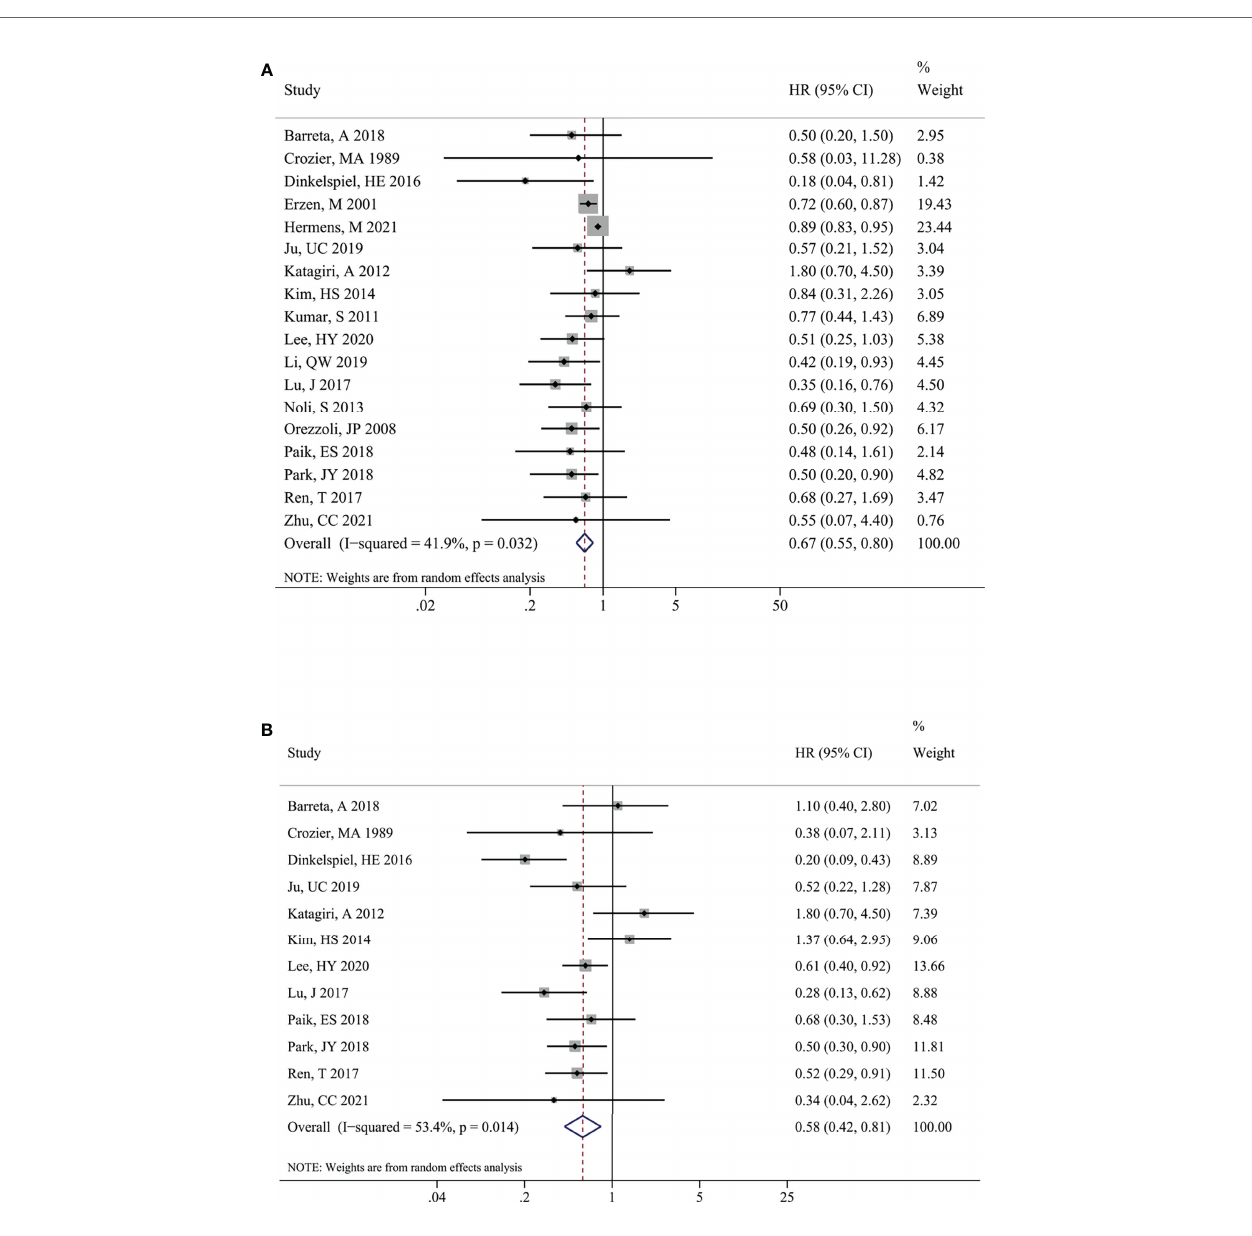
FIGURE 2 | Impact of endometriosis on the prognosis of total OC. Forest plots showing the pooled results for endometriosis on overall survival (A) and progression- free survival (B) of total OC patients. OC, ovarian